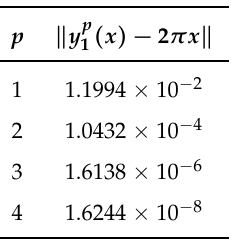
Table 1. Distance of the first step of iterative methods (10) to the exact solution of integral Equation (14).